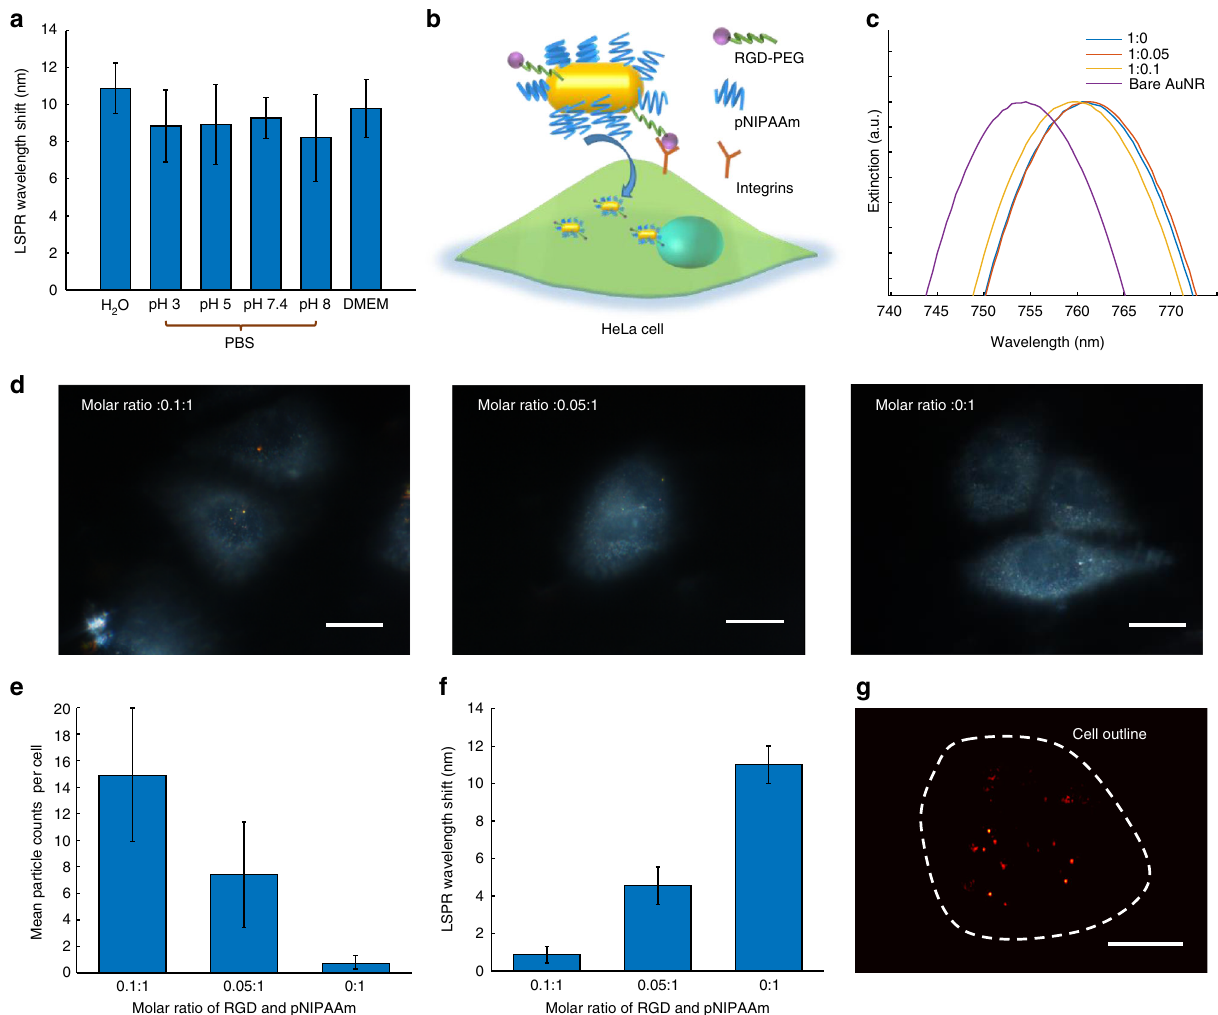
Fig. 5 Optimization of molar ratio between Arg-Gly-Asp (RGD) peptides and pNIPAAm during AuNRs@pNIPAAm/RGD assembly. a LSPR wavelength shifts of AuNRs@pNIPAAm in water, phosphate buffered solutions (PBS) with pH from 3 to 8 and the cell culture media when the temperature increases from 25 to 40 °C. Error bars, ± 1 s.d. with n = 20 each. b Schematic illustration of the HeLa cell-targeting AuNRs@pNIPAAm/RGD. c UV − vis spectra of bare gold nanorods and AuNRs@pNIPAAm/RGD assembled in mixture of RGD and pNIPAAm with molar ratio of 0.1:1, 0.05:1, and 0:1. d Broadband dark- fi eld images of HeLa cells incubated with 40 pM AuNRs@pNIPAAm/RGD for 5 h. Scale bar is 20 μ m. e Mean particle counts in a cell in the same sample shown in d . Error bars, ± 1 s.d. with n = 20 each. f Temperature-induced LSPR wavelength shifts of AuNRs@pNIPAAm/RGD particles in d . Error bars, ± 1 s.d. with n = 10 each. g The scattering image of AuNRs@pNIPAAm/RGD in a HeLa cell by the HILO sheet dark- fi eld microscope. Scale bar is 10 μ